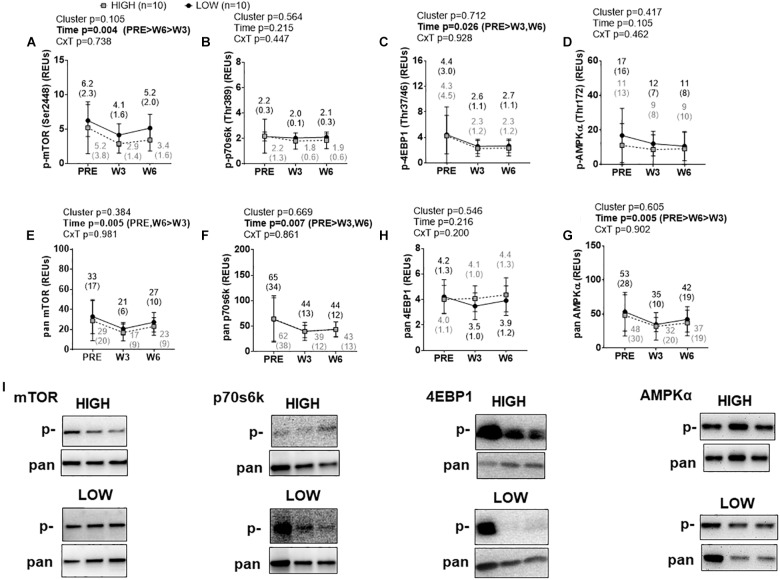
PRE, W3, and W6 mTORc1 signaling marker differences between LOW and HIGH responders. (A–D) Phosphorylated (p-) mTORc1 targets. There were no significant cluster effects or cluster × time interactions for said markers. p-mTOR and p-4EBP1 demonstrated significant time effects. (E–H) Total (pan) mTOR, p70s6k, 4EBP1, and AMPKα. Again, there were no significant cluster effects or cluster × time interactions for said markers, although there were significant time effects for pan mTOR, pan p70s6k, and pan AMPKα. Values presented in line graphs are mean (standard deviation) values. (I) Representative Western blot images for a low and high responder.